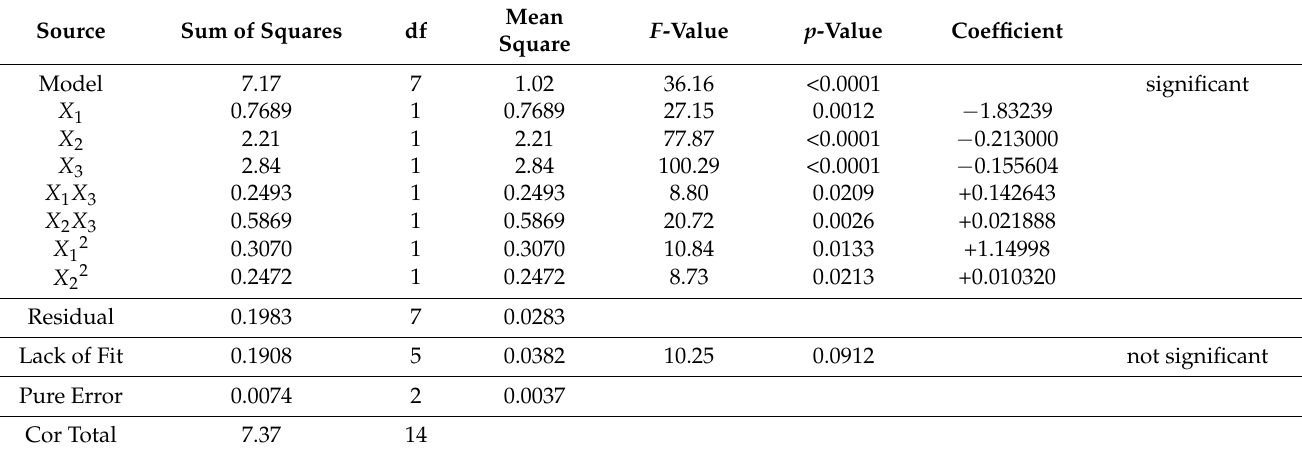
Table 4. ANOVA results for response: unit energy